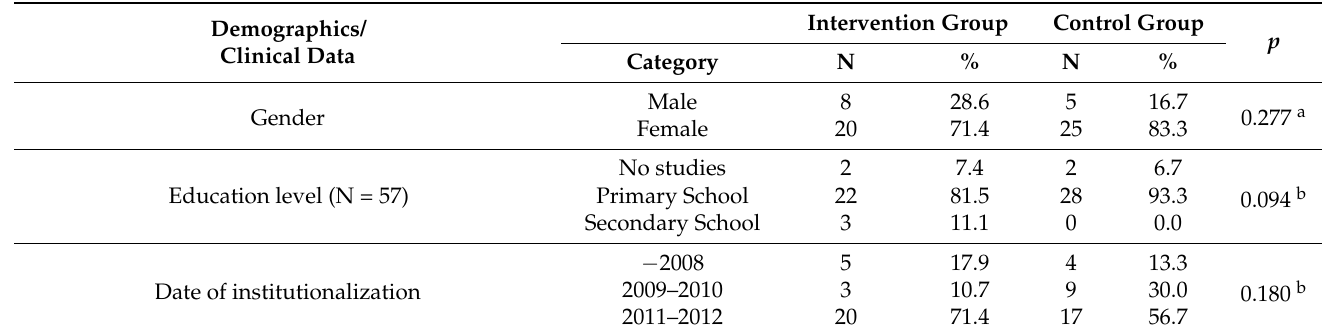
Table 1. Socio-demographic characteristics of the sample at baseline.